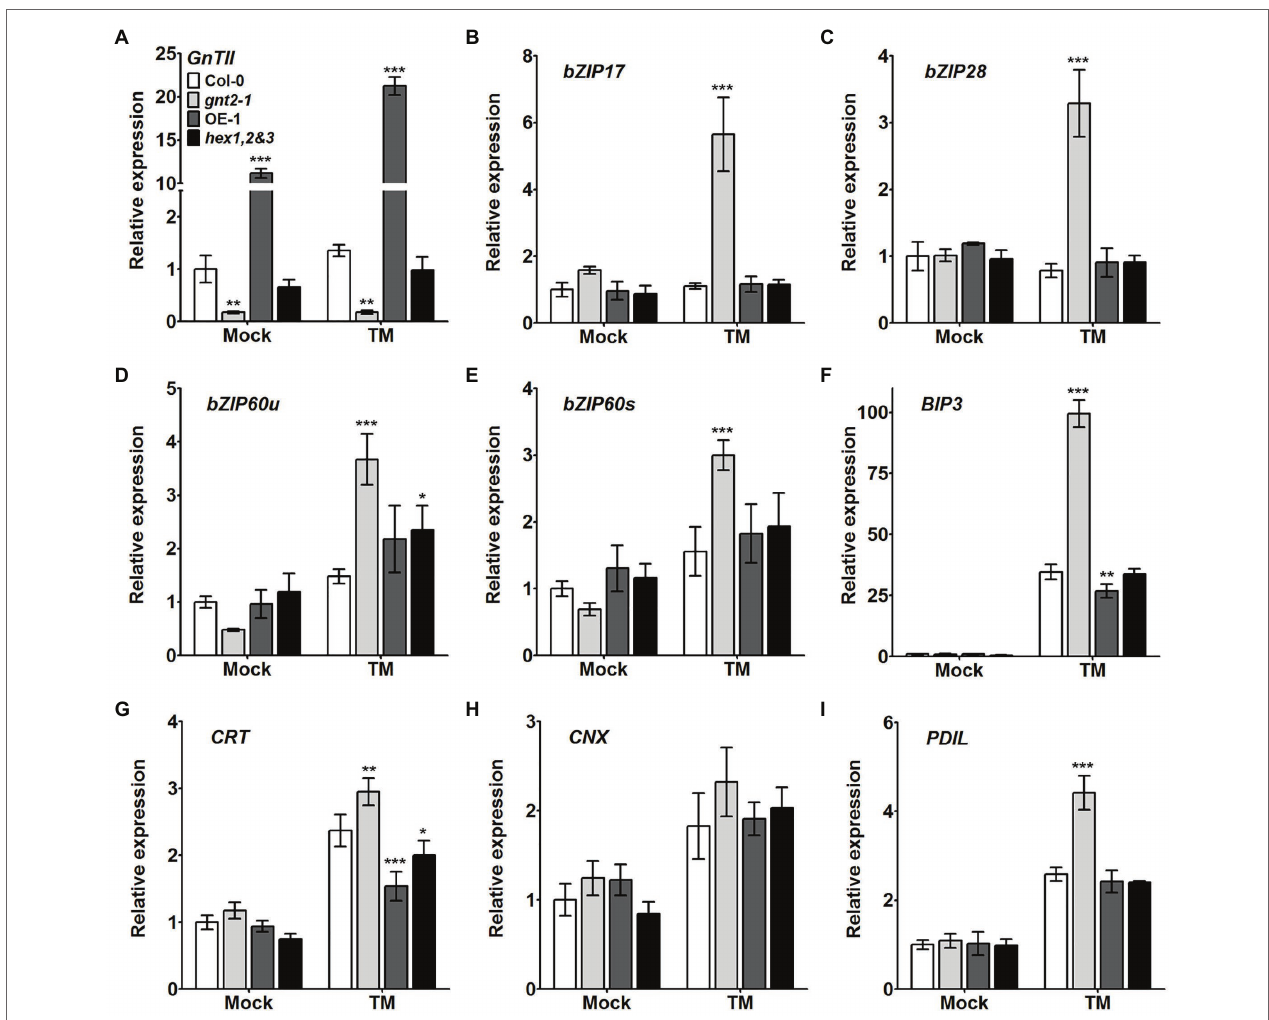
FIGURE 3 | Expression of UPR-related genes is higher in the gnt2-1 mutant than in Col-0 plants under prolonged ER stress. (A) Analysis of GnTII expression in Col-0, gnt2-1 , OE-1, and hex1,2&3 plants. (B–I) Relative expression of mRNAs encoding various UPR-related genes in Col-0, gnt2-1 , OE-1, and hex1,2&3 plants analyzed by qPCR. Total RNA was extracted from 12-day-old seedlings grown on MS medium with or without TM (20 μ g l − 1 ). The experiment was performed independently three times (three biological replicates) and normalized with respect to β -TUBULIN expression. Data represent mean ± SEM of three independent experiments. Asterisks indicate statistically significant differences (* p < 0.05, ** p < 0.01, and *** p < 0.001) as determined by two-way